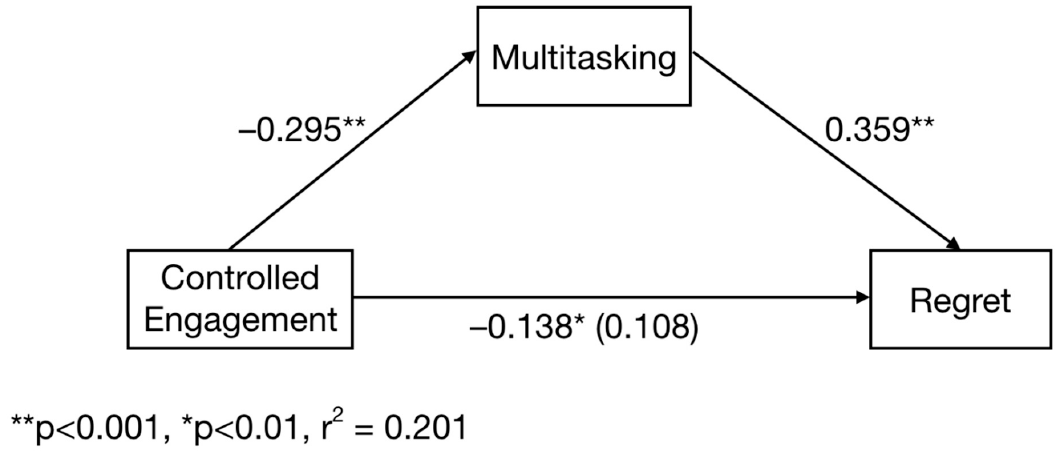
Figure 1. Mediation model for effects of narrative completion (NC) on regret via multitasking for higher degrees of viewer attentiveness (HVAS) binge-watching. Total indirect effect is in parentheses.